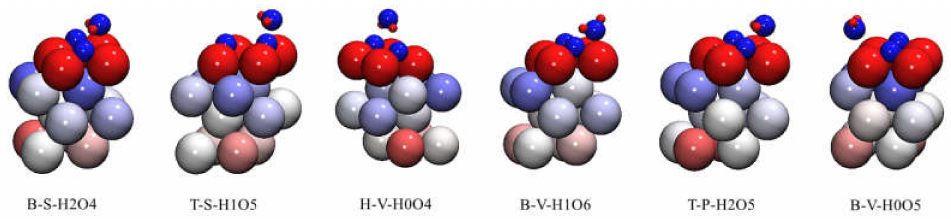
Figure 9. The atom charge of stable adsorption configuration obtained by preferential adsorption of O 2 : red indicates positive charge, blue indicates negative charge and the charge range is − 0.30 e ~0.30 e